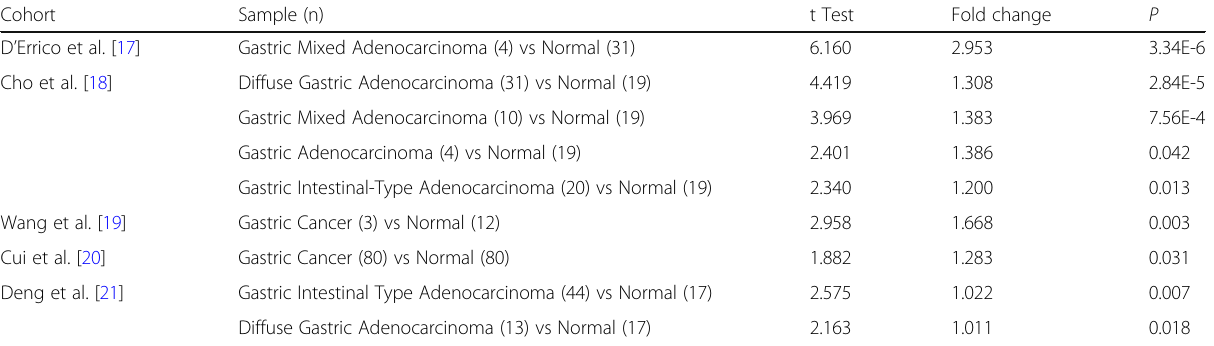
Table 1 Oncomine analysis of MRE11 expression in GC (total of 5 GC cohorts) Cohort